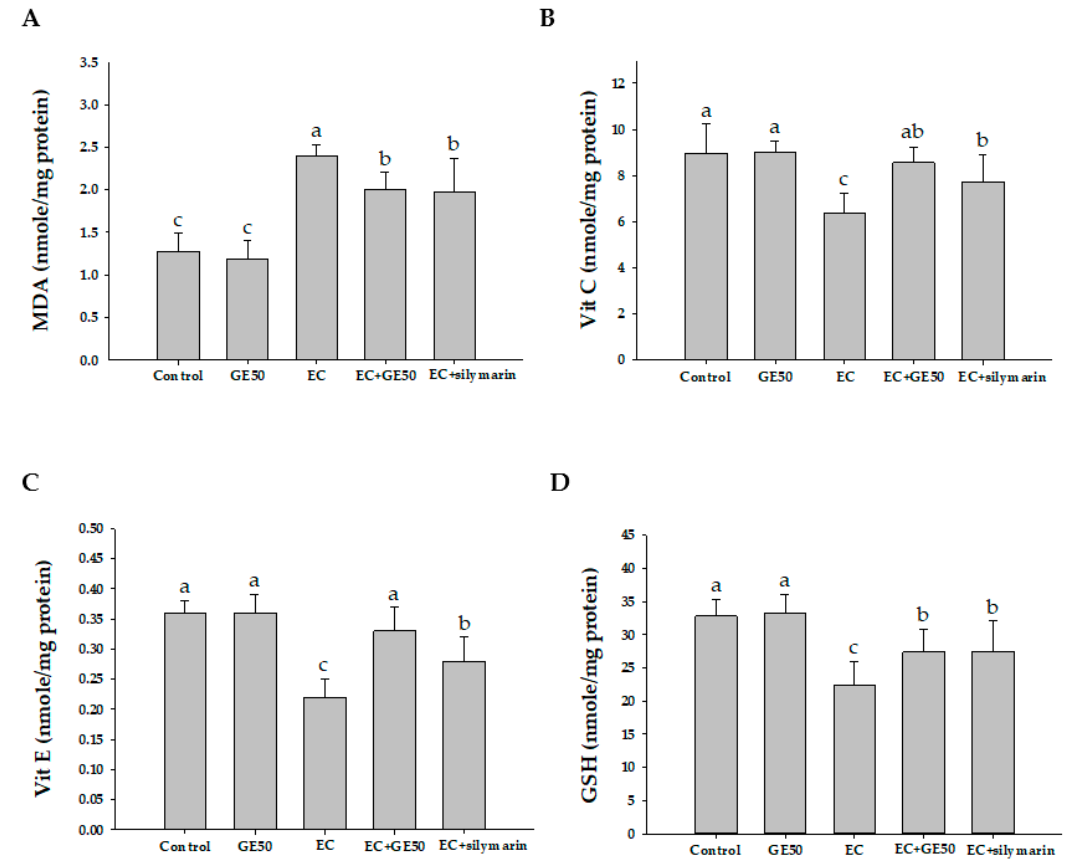
Figure 2. E ff ects of oral administration of GE50 over six consecutive weeks on malondialdehyde (MDA) ( A ), vitamin C ( B ), vitamin E ( C ), glutathione (GSH) ( D ) levels in the livers of rats treated with ethanol + CCl 4 . The data are presented as mean ± S.D. of 10 rats. One-way ANOVA and Scheffe’s method were used to analyze the differences between the means. a–c Mean values with different letters in the same row are significantly different ( p < 0.05) according to Duncan’s multiple-range test. Control group; GE50 group; EC group: Ethanol + CCl 4 ; EC + GE50 group: Ethanol + CCl 4 + GE50; EC + silymarin group: ethanol + CCl 4 + silymarin.